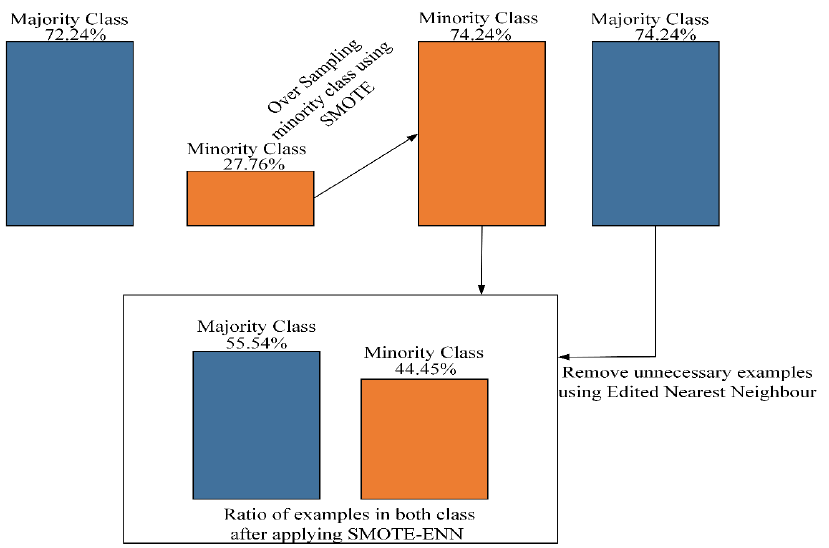
Figure 4. Illustration of SMOTE-ENN for Resort hotel (H1) [39].